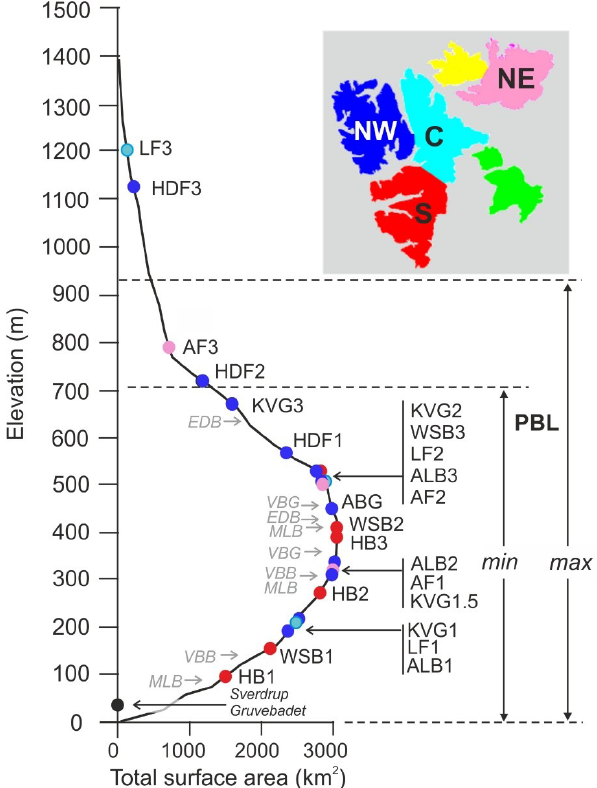
Figure 2. Snow sampling sites visited during the spring 2016 glacier survey, plotted with respect to elevation and glacier surface hypsometry (black line; from James et al., 2012). Each circle corre- sponds to a sampling location, and those on glaciers are labeled as in Table 2 and color-coded per region (inset; from König et al., 2014). The grey arrows and symbols to the left of the hypsometric curve indicate elevations at which surface snow samples were collected during the spring 2017 survey. Also shown are the minimum (win- ter) and maximum (summer) thicknesses of the planetary boundary layer (PBL) in the maritime sector of the European Arctic, based on ERA-40 reanalysis over 1969–2001 (Esau and Sorokina,